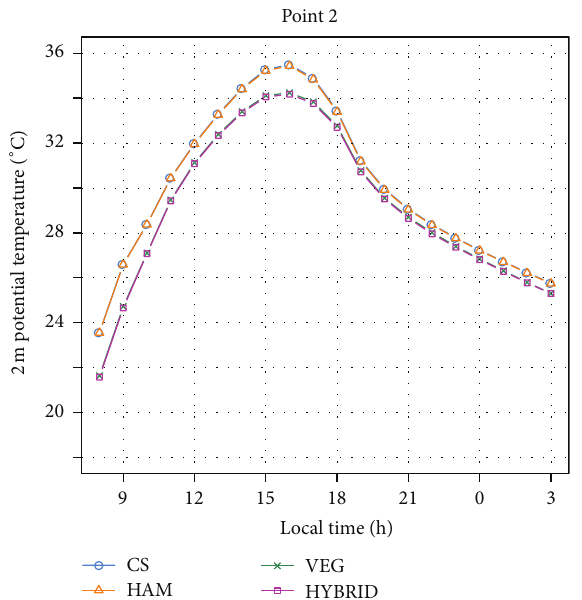
Figure 16: 2 m potential temperature time series at Point 2.